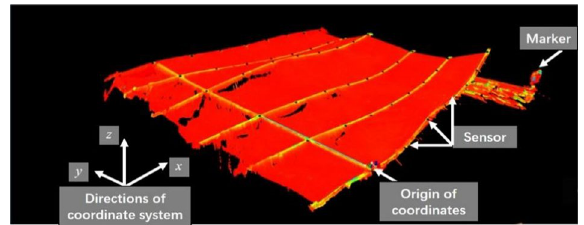
Fig. 11 Terrain data obtained by 3D laser scanner